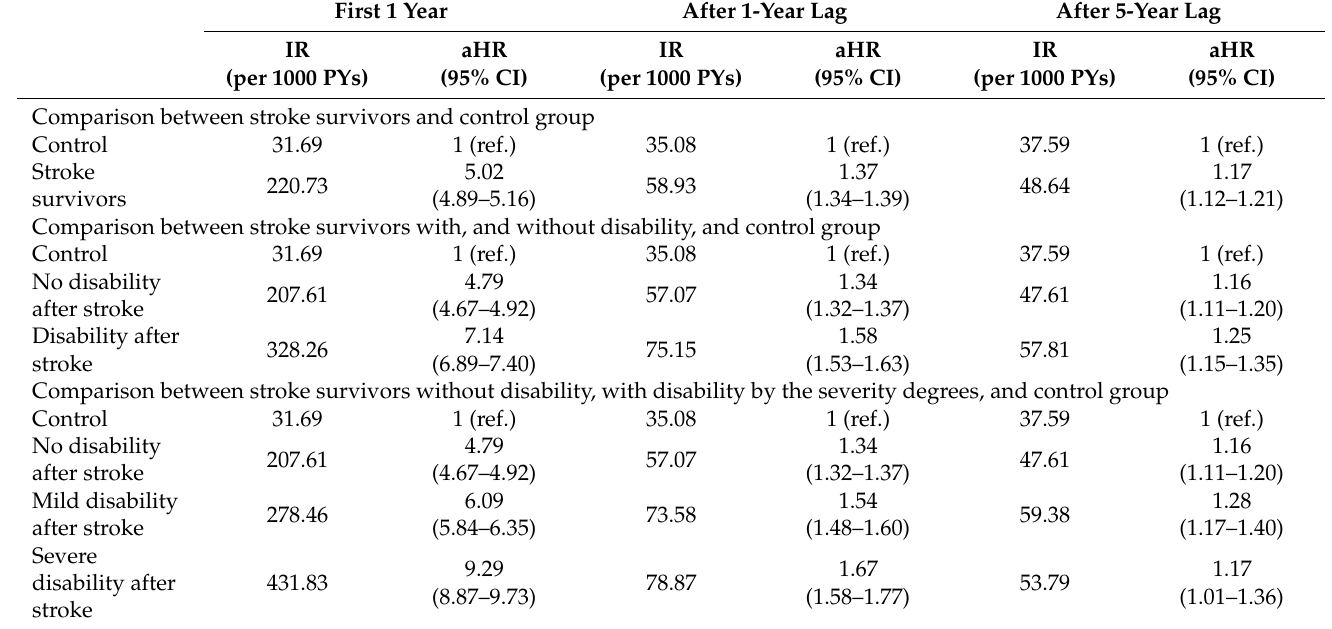
Table 3. Comparison of the risk of developing depression in stroke survivors and matched control group.